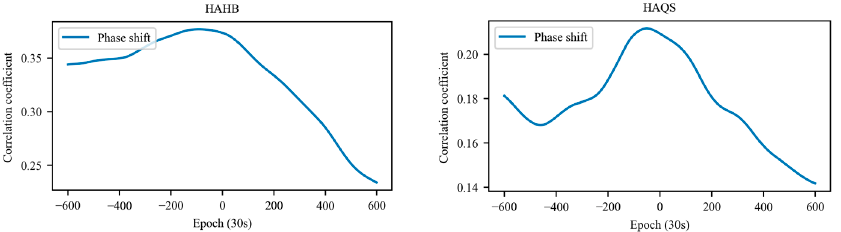
Figure 10. Correlation coefficients between the PWV and rainfall for station HAHB and HAQS, re- spectively.